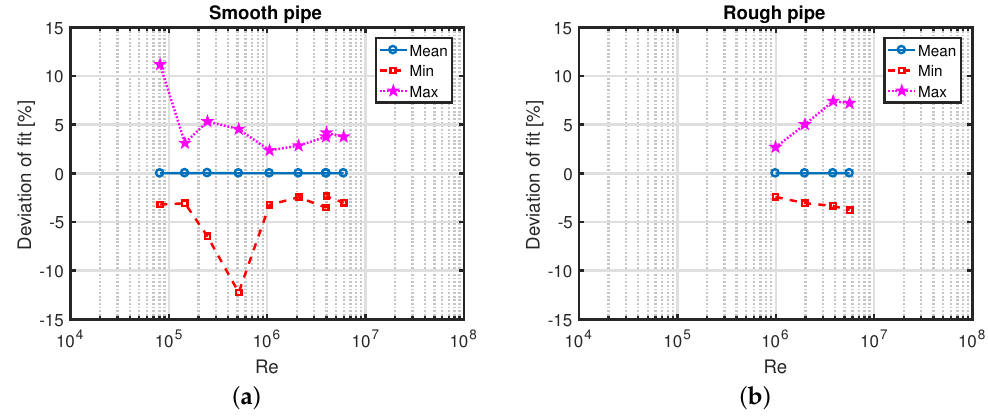
Figure A2. Deviation of fits to measurements; ( a ): smooth pipe, ( b ): rough pipe. The core and wall fits for the smooth and rough pipe fits are compared in Figure